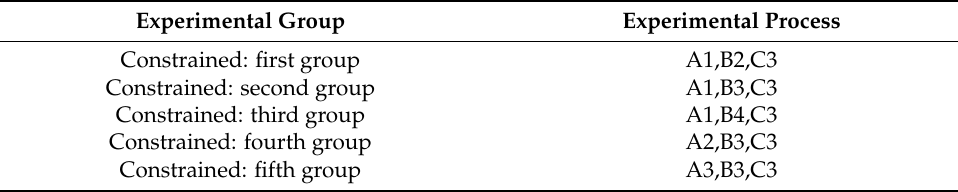
Table 3. Experiment process of 5 constrained state groups.